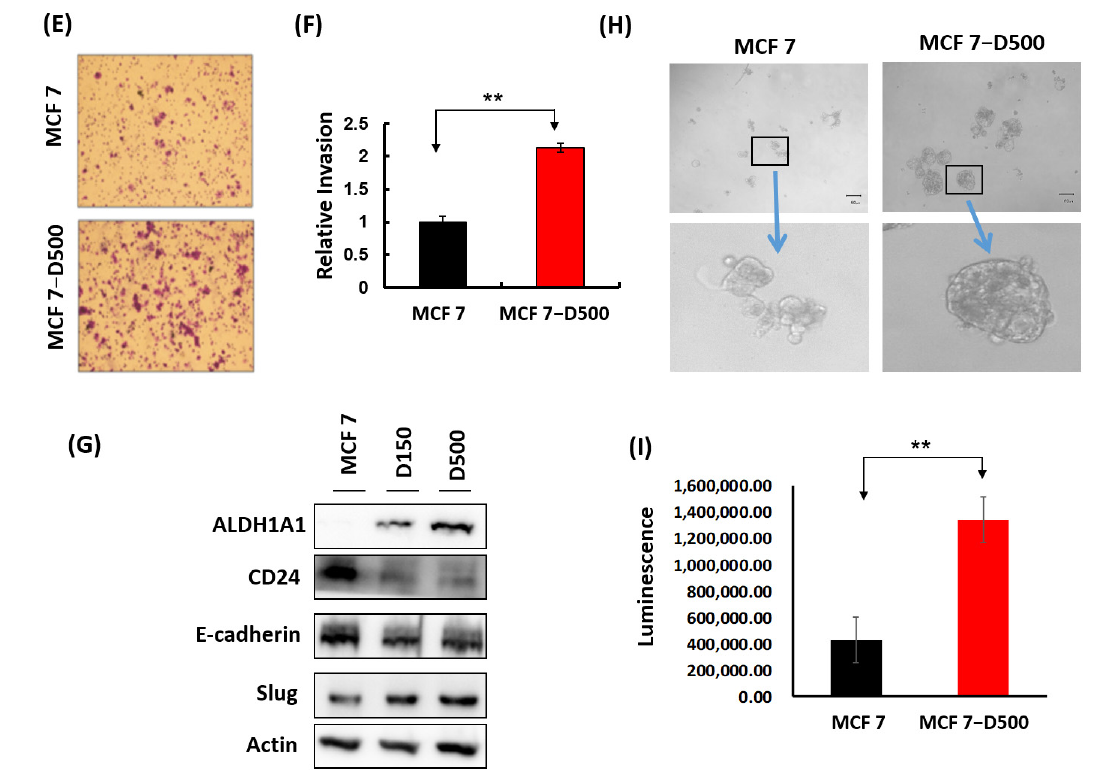
Figure 1. Generation and characterization of MCF-7 cells with doxorubicin resistance. ( A ) The flowchart for establishing doxorubicin resistance in MCF-7 cells and the morphology of MCF-7 control and MCF-7-D500 cells was observed using a microscope. ( B ) The proliferation of MCF-7 parental and doxorubicin-resistant MCF-7 cells (MCF-7-D100, MCF-7-D150, MCF-7-D300, and MCF-7-D500). ( C , D ) The apoptosis assay of MCF-7 and MCF-7-D500 cells after doxorubicin (500 nM) treatment for 24 h. ( E , F ) The cell motility of MCF-7 and MCF-7-D500 cells. ( G ) The cancer stem cell-related and EMT-related markers were examined. ( H , I ) The quantification of the mammosphere-forming efficiency of MCF-7 and MCF-7-D500 cells (* p < 0.05; ** p < 0.01, *** p < 0.001).